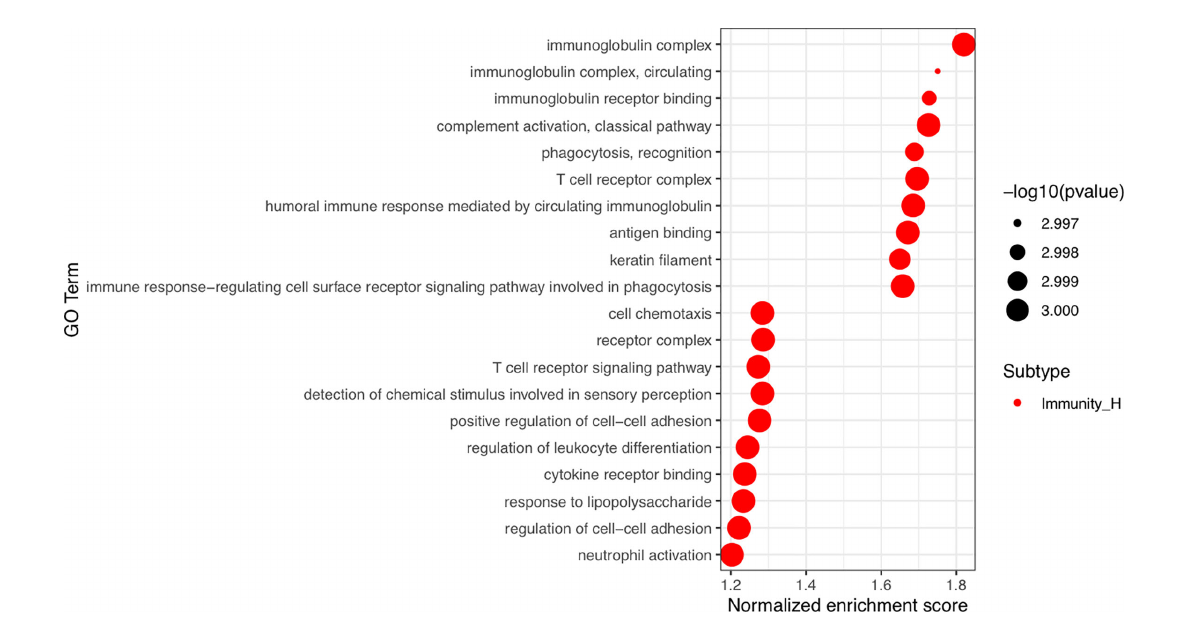
FIGURE 5 | Identi fi cation of cutaneous melanoma subtype-speci fi c GO terms. Top 10 GO terms enriched in the Immunity_H and Immunity_L groups. GO, Gene